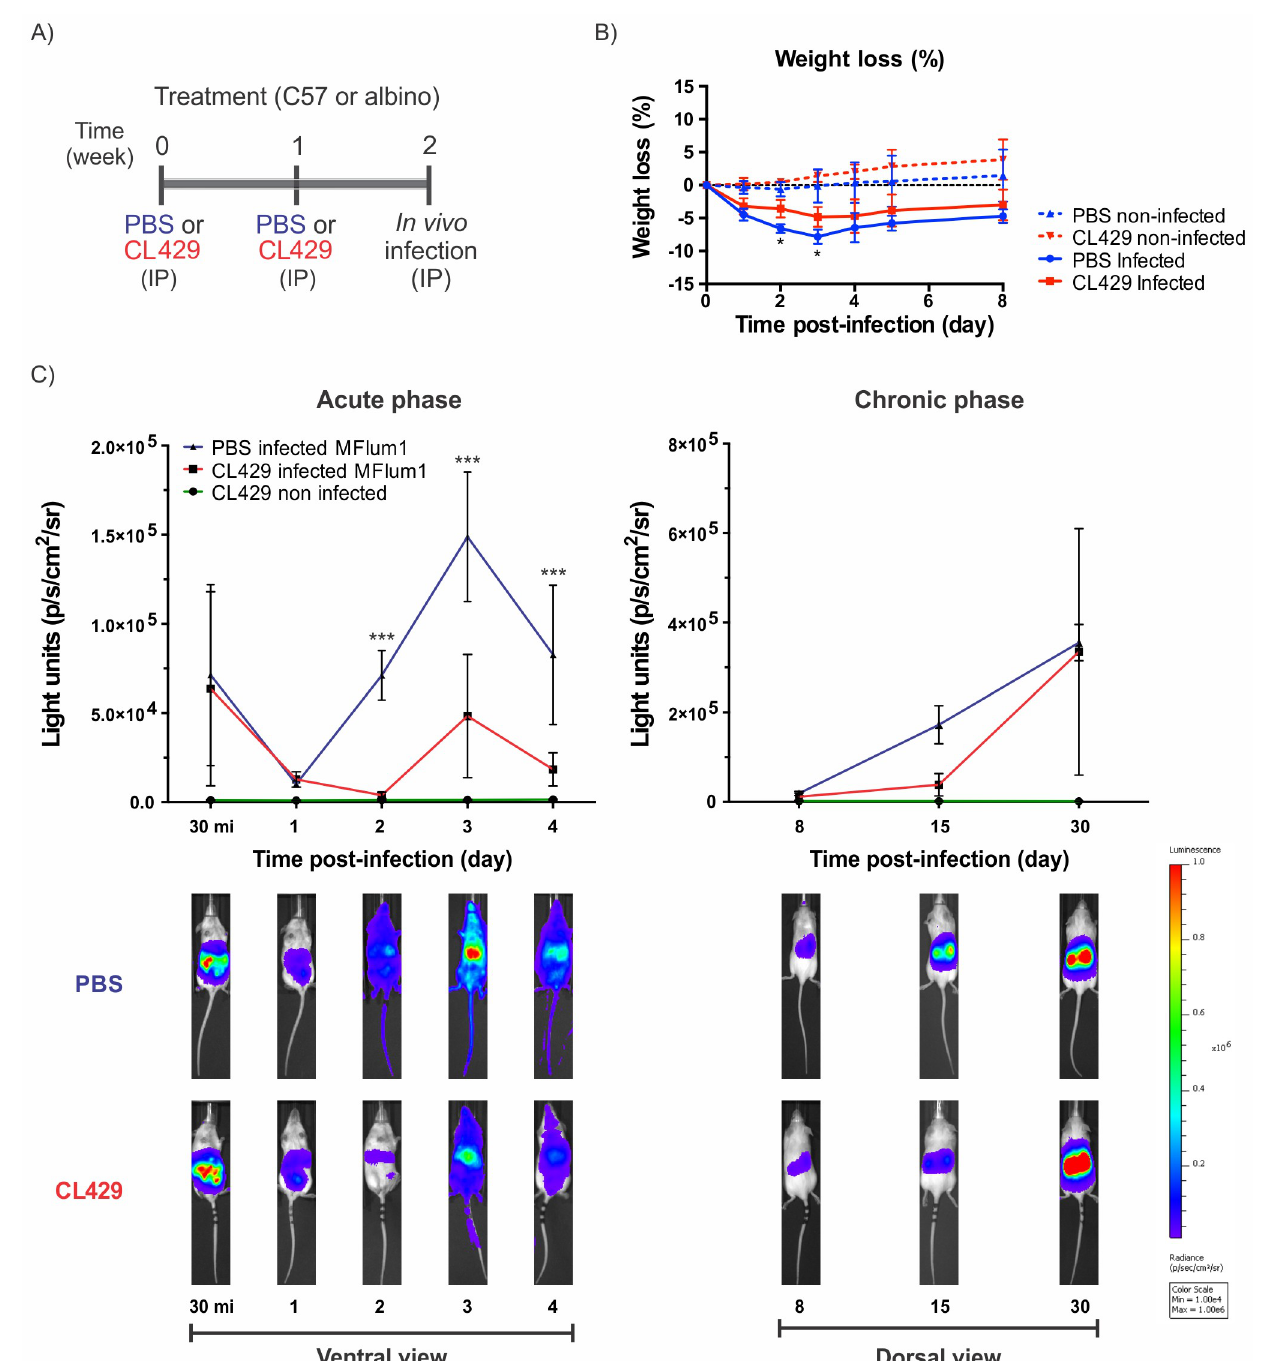
Fig 2. Treatment with CL429 enhances leptospiral clearance in the acute but not the chronic phase of infection. A) Chronogram of the experiment. C57BL/6 WT mice were injected IP with 200 μ L PBS containing 2.5% DMSO (vehicle) or 25 μ g CL429 2 and 1 weeks before IP infection. B) C57BL/6 WT treated mice (n = 5) were IP infected with 5x10 7 leptospires, and weight variation monitoring, expressed as a percentage versus of the weight on the day of infection, was used to follow the severity of acute infection. C) Live imaging of albino (C57BL/6 B6(Cg)-Tyr c-2J /J) treated mice IP infected with a sublethal dose of 5x10 7 bioluminescent L . interrogans serovar Manilae bioluminescent strain MFlum1. During the acute phase of infection, mice were daily imaged (ventral view) from day 0 (30 minutes post-infection) to day 4. During the chronic phase from day 8, mice were imaged in the dorsal view to measure renal colonization. The lower panel shows a representative example of the follow-up of one mouse. The upper panel shows the quantification of data from n = 4 mice. The blue to red scale is proportional to the intensity of bioluminescence, reflecting the number of live leptospires. Data represent 1 of 2 independent experiments (n = 4 or 5). Curve comparison was performed by 2-way ANOVA comparing PBS vs clodronate at each corresponding time point. � p - value < 0.05; �� p -value < 0.01; ��� p -value < 0.001.